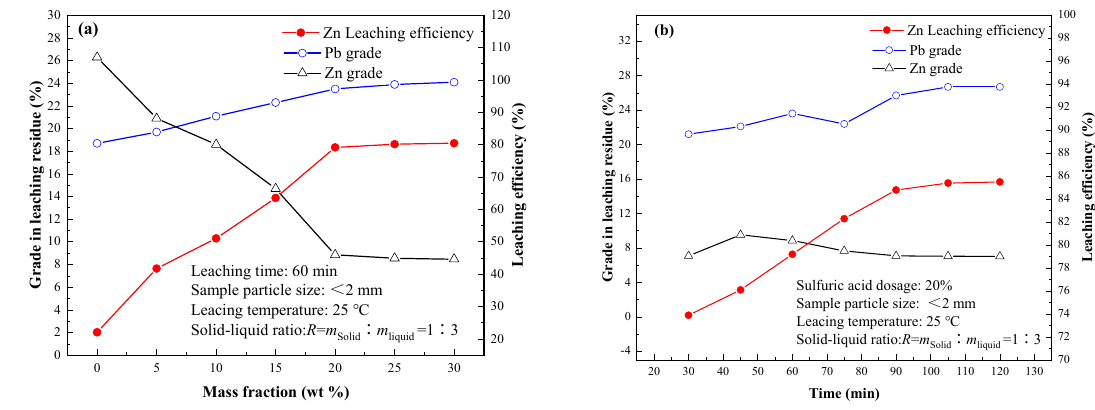
Figure 4. E ff ect of sulfuric acid dosage ( a ) and leaching time ( b ) on the leaching e ffi ciency of zinc and metal grades in the leaching Figure 4. Effect of sulfuric acid dosage ( a ) and leaching time ( b ) on the leaching efficiency of zinc and metal grades in the leaching residue.